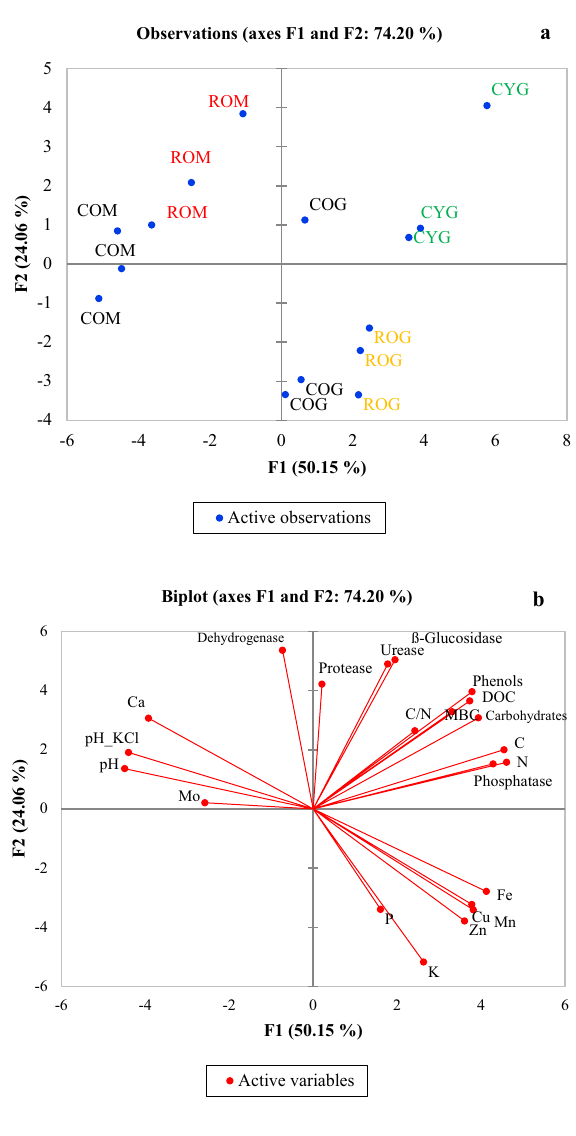
Figure 3. Principal component analysis shown as biplots of scores. ( a ) Sites, ( b ) variables loadings. ROM black locust at Locone Lake, COM degraded but not reforested soils at Locone Lake, CYG cypress at Lama Giulia, ROG black locust at Lama Giulia, COG degrade but not reforested soils at Lama